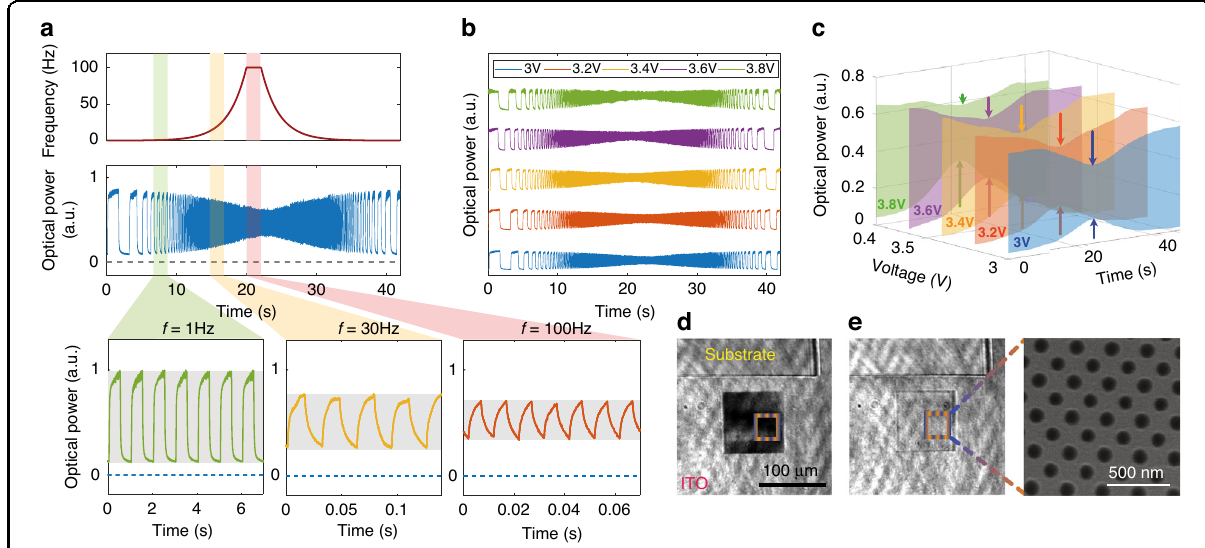
Fig. 3 Temporal modulation of the metasurface. a Switching performance of the metasurface at different frequencies. The starting frequency is 0.25 Hz, reaching 100 Hz in 20 seconds on a logarithmic increment. Then the system operates with a 100 Hz switching time for 2 seconds and reverts to the 0.25 Hz in 20 seconds by a logarithmic decrement. The modulation performance of the metasurface is shown in the bottom plots at the frequency of 1 Hz (green), 30 Hz (yellow) and 100 Hz (pink). b Switching performance of the system at different bias voltages. c Lower and upper boundaries of the metasurface transmission intensity across the frequency sweep at different voltage biases. Optical images are taken from the metasurface d at room temperature and e when it is heated to 200 °C. The SEM image on the right-hand side shows the silicon